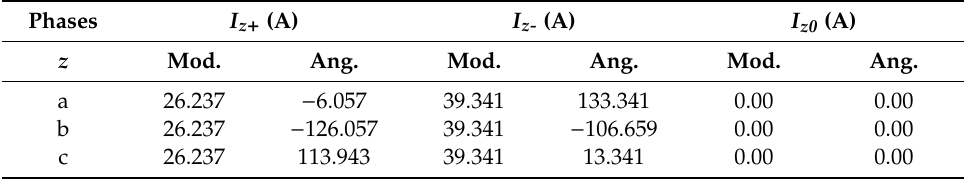
Table 6. Positive-, negative-, and zero-sequence line currents in the bus after ZSCC and SVC collocation. Phases I z + (A) I z- (A) I z0 (A) z Mod. Ang.